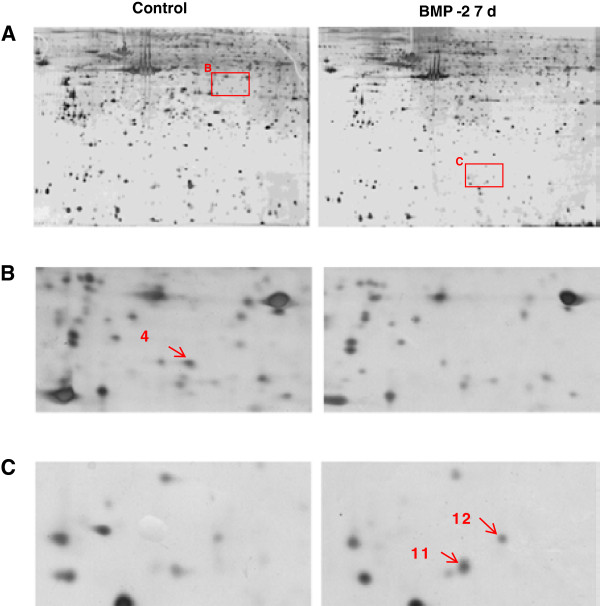
Proteomics analysis of protein expression profiles in rhBMP-2-induced BMSCs. (A) 2D gel electrophoresis maps of BMSCs without or with rhBMP-2 induction (labeled as control and BMP-2, respectively). (B and C) Close-up images of cropped sections of 2-DE maps shown in (A). Protein number 4, LASP1; Number 11 and 12, ferritin light and heavy chains.